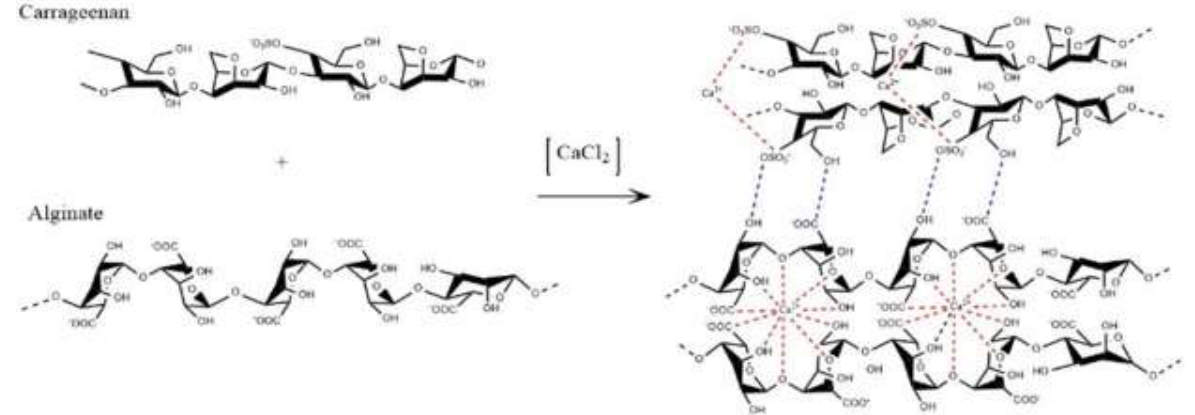
Figure 7. Interaction between alginate and carrageenan in CaCl 2 solution FT-IR